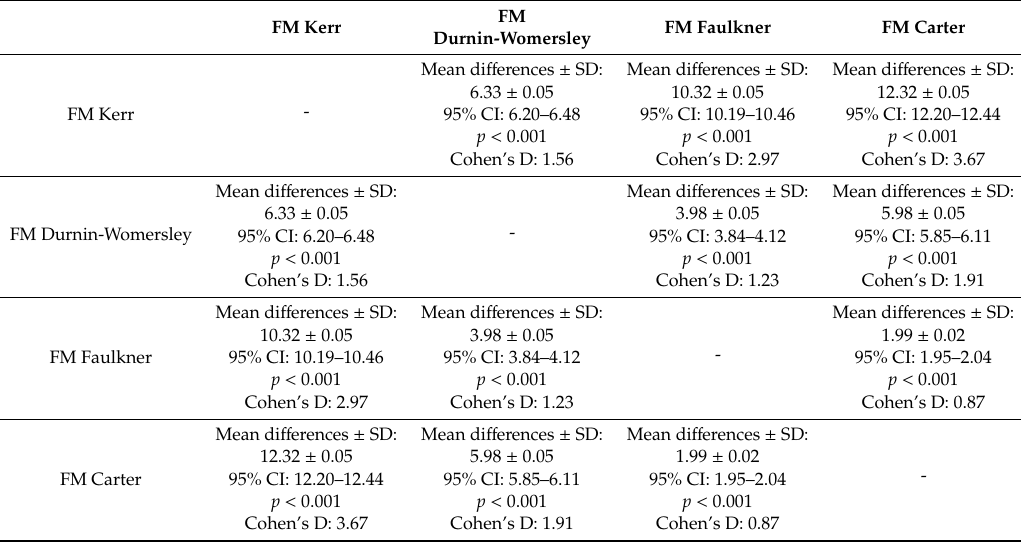
Table 2. Di ff erences between fat mass equations in kg.